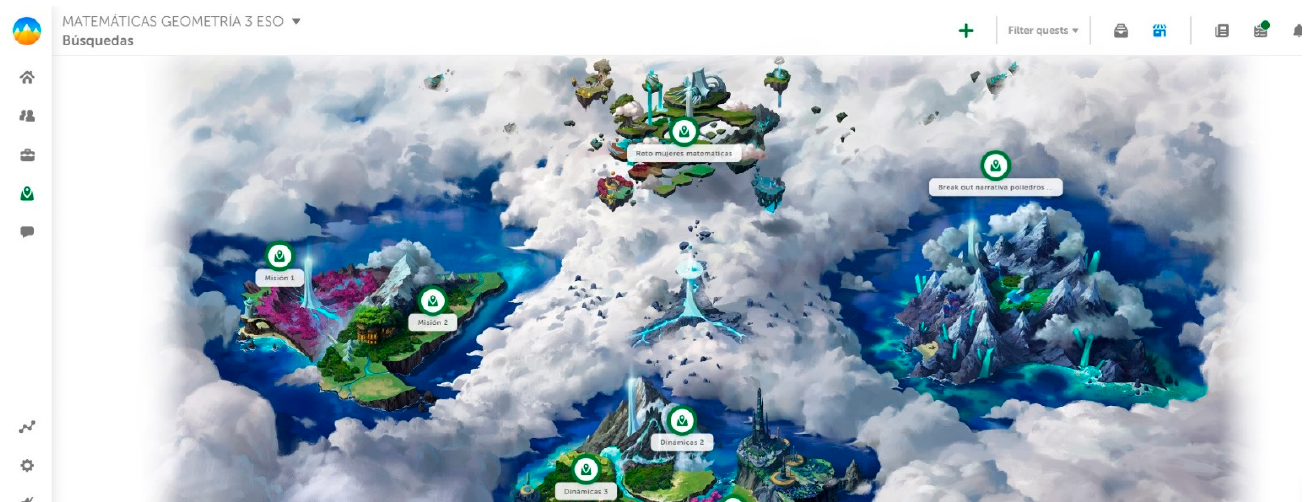
Figure 5. Map with the proposed challenges and sessions in Classcraft.